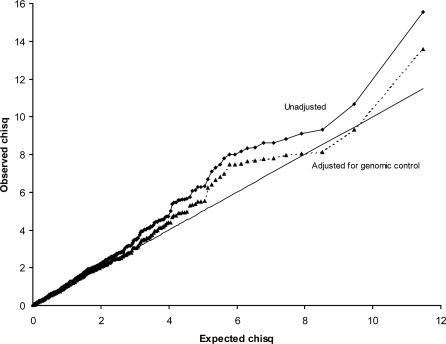
Q–Q Plot for Association of 710 SNPs in Candidate Genes with Breast Cancer Based on First Stage Data